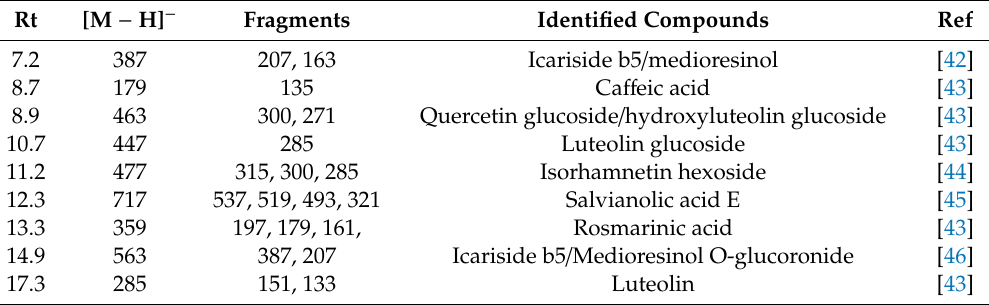
Table 4. LC-MS / MS results of 70% MeOH extract of S. aramiensis .